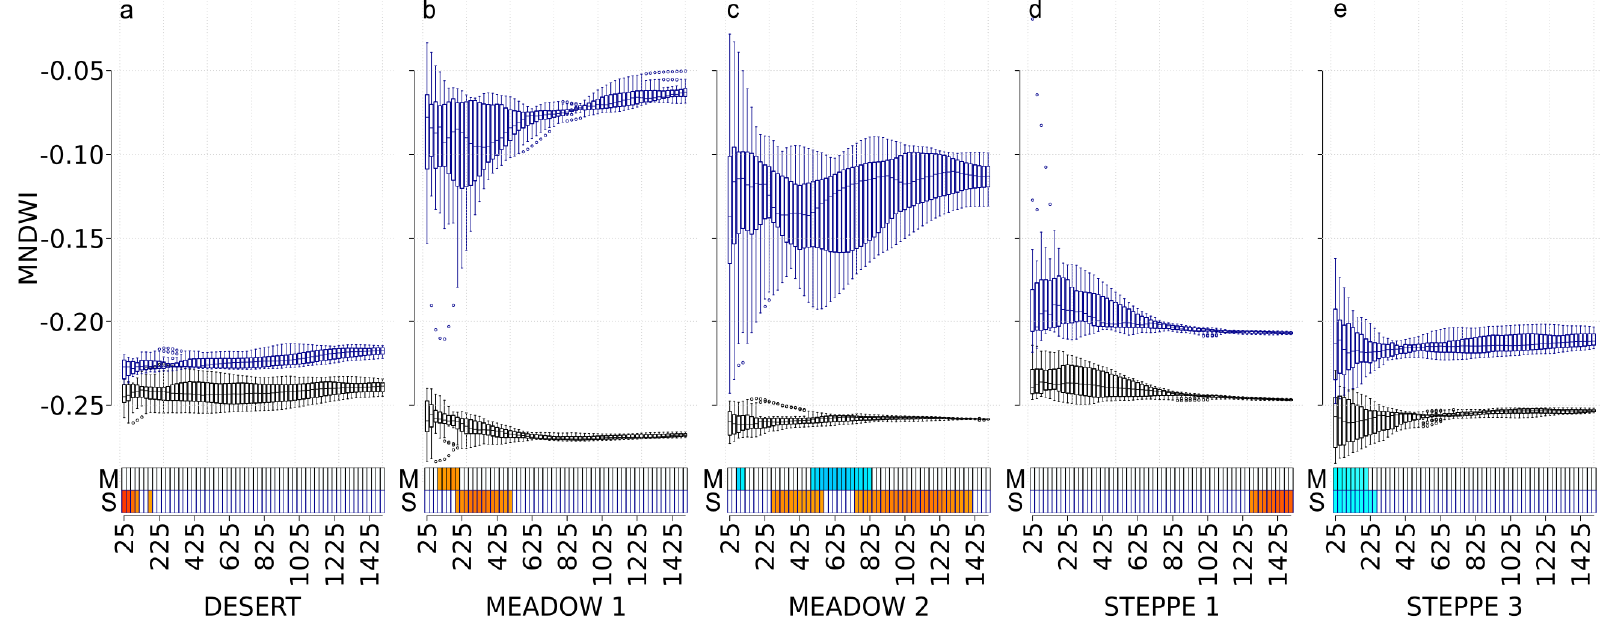
Figure 6. MNDWI values at each scale and correlations with carabid abundances for the desert steppe (a), the meadow steppe 1 and 2 (b and c, respectively), and the typical steppe 1 and 3 (d and e, respectively). Boxplots represent the MNDWI values with a black border for the May 2017 Landsat image (M) and with a dark-blue border for the September 2017 Landsat image (S). For each boxplot, a different background color indicates a significant difference in MNDWI values using the Tukey test. The x -axis presents the different spatial scales used in the analysis (cardinal distances in meters representing circle radius ranging from 25 to 1500 m). The correlation with carabid abundances is represented with rectangles at the bottom of each graph, using a gradient from blue to red (dark blue corresponds to a negative correlation, dark red corresponds to a positive correlation, and white corresponds to no significant correlation).